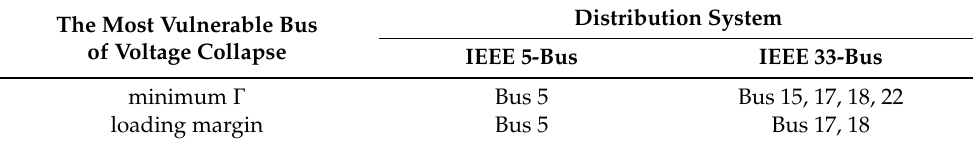
Table 1. The most vulnerable bus of voltage collapse detection on IEEE 5-bus and 33-bus distribution test